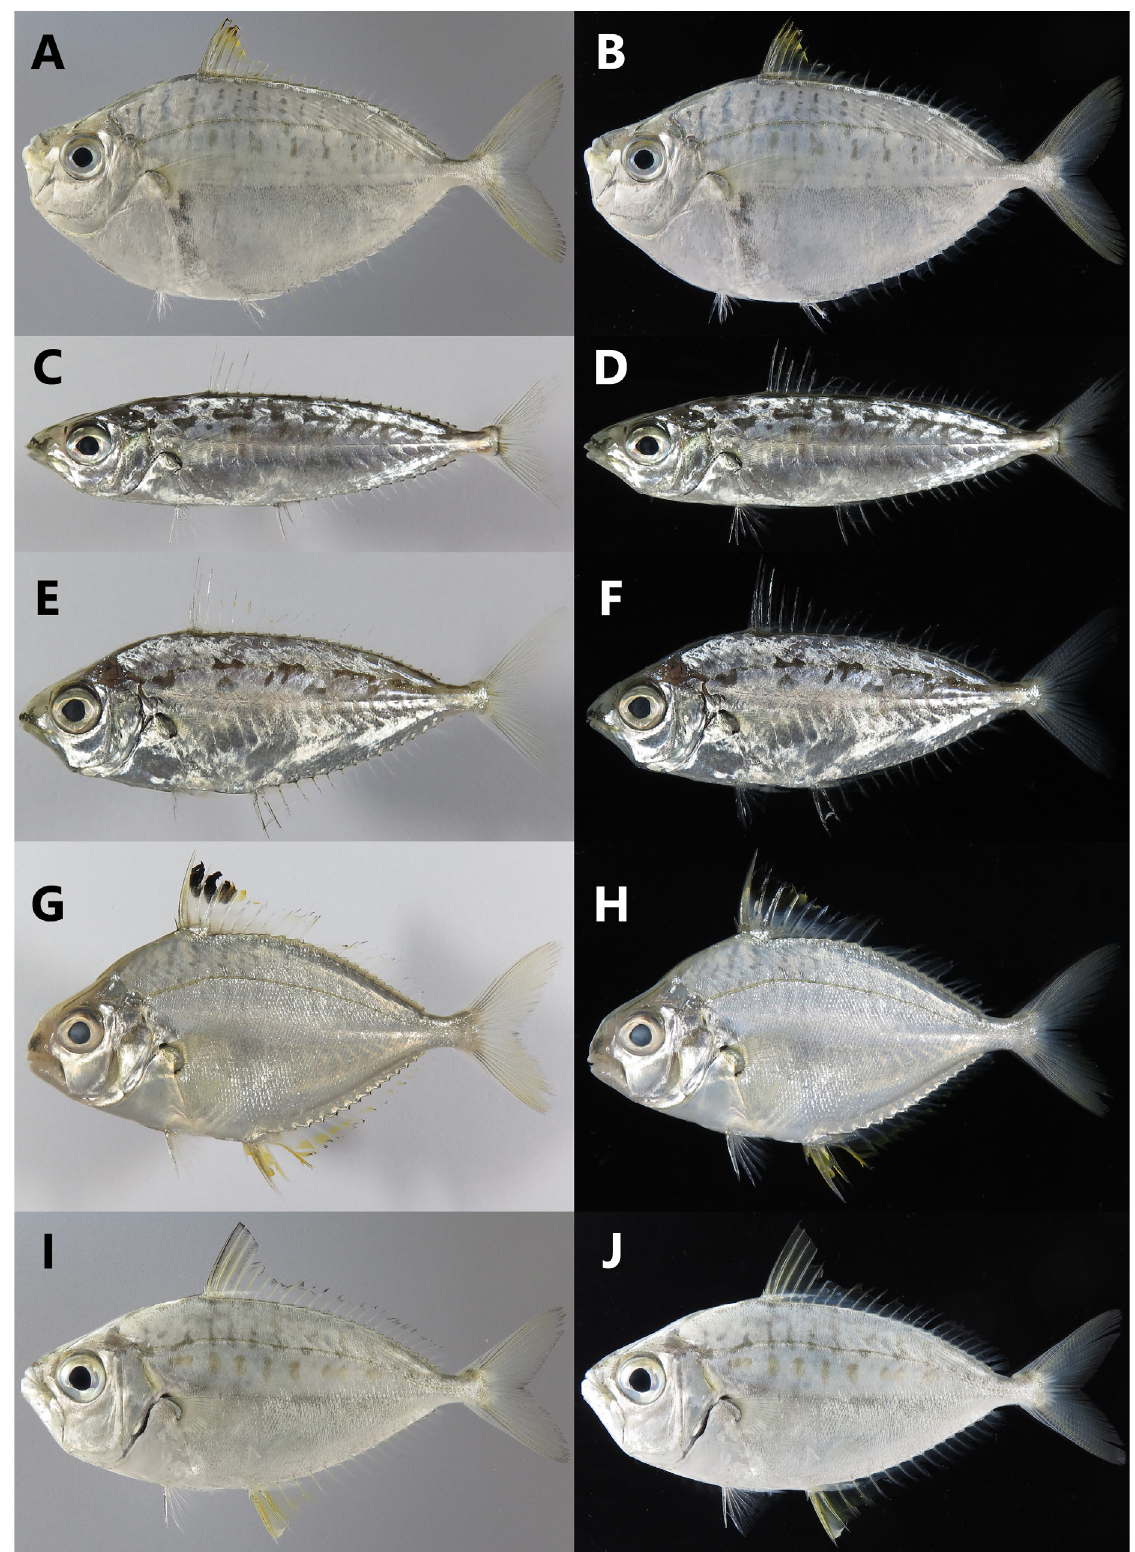
Figure 2. Color photographs of 5 species of Leiognathidae from Miyazaki Prefecture, southern Japan. A, B. Deveximentum indicium , KPM-NI 42050 (photo number KPM-NR 176933A, B respectively), 99.4 mm SL, Kadogawa Bay, set net, 8 m depth. C, D. Equulites popei , KPM-NI 42111, (KPM-NR 176937A, B), 65.6 mm SL, coast of Ichiki, Kushima City, set net, 25 or 48 m depth. E, F. Equulites rivulatus , KPM-NI 42104, (KPM-NR 176936A, B), 50.9 mm SL, Kadogawa Bay, trawl, ca 40 m depth; G, H. Eubleekeria splendens , KPM-NI 41909, (KPM-NR 176930A, B), 70.2 mm SL, Kadogawa Bay, set net, 8 m depth. I, J. Gazza minuta , KPM-NI 42053, (KPM-NR 176935A, B), 81.7 mm SL, Kadogawa Bay, set net, 8 m depth. Photos by A. Murase (C, D, E, F, G, H) and R. Miki (A, B, I,